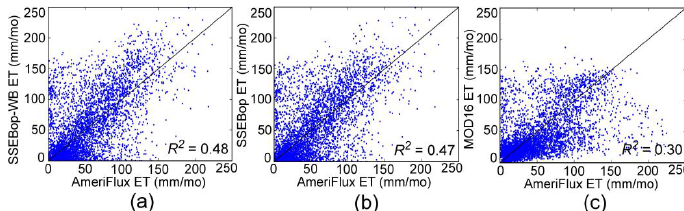
Figure 7. Scale factor map used in converting SSEBop ET estimates to SSEBop/Water-Balance (SSEBop-WB) ET estimates. Locations of AmeriFlux towers are also shown. This map represents the